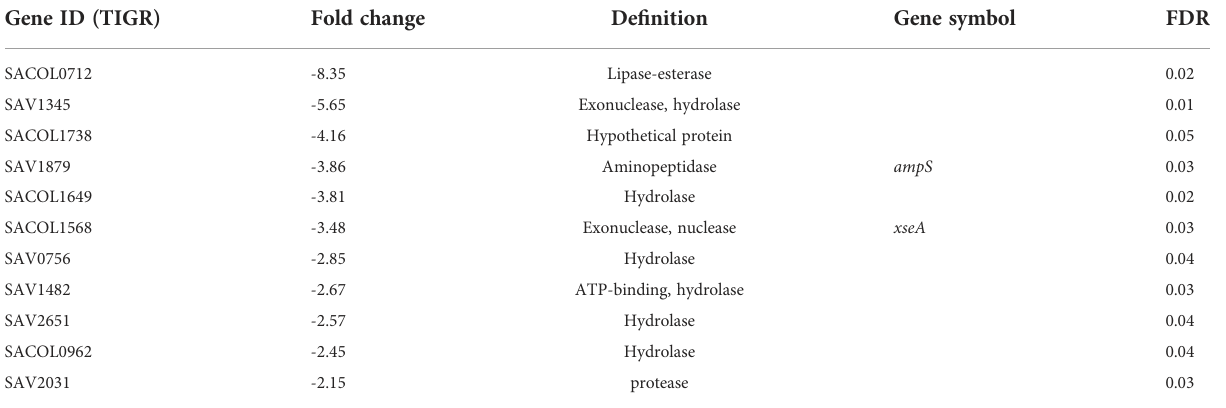
TABLE 7 Genes identi fi ed in the hydrolase category (repressed).